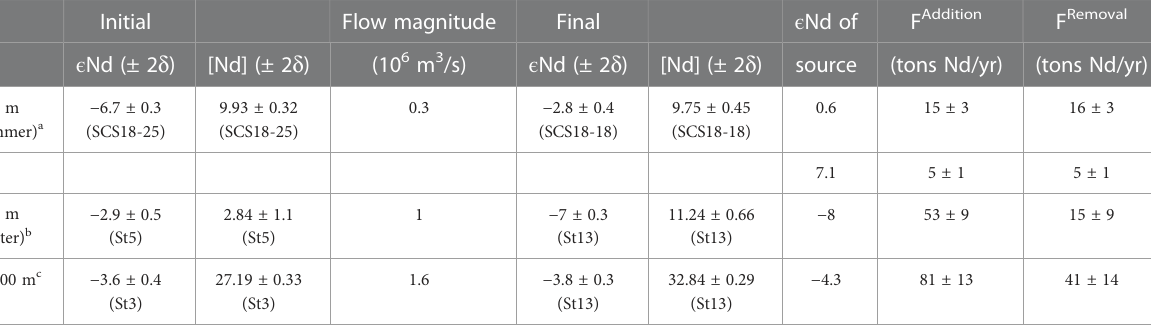
TABLE 2 Estimated Nd inputs from surrounding rivers. Initial